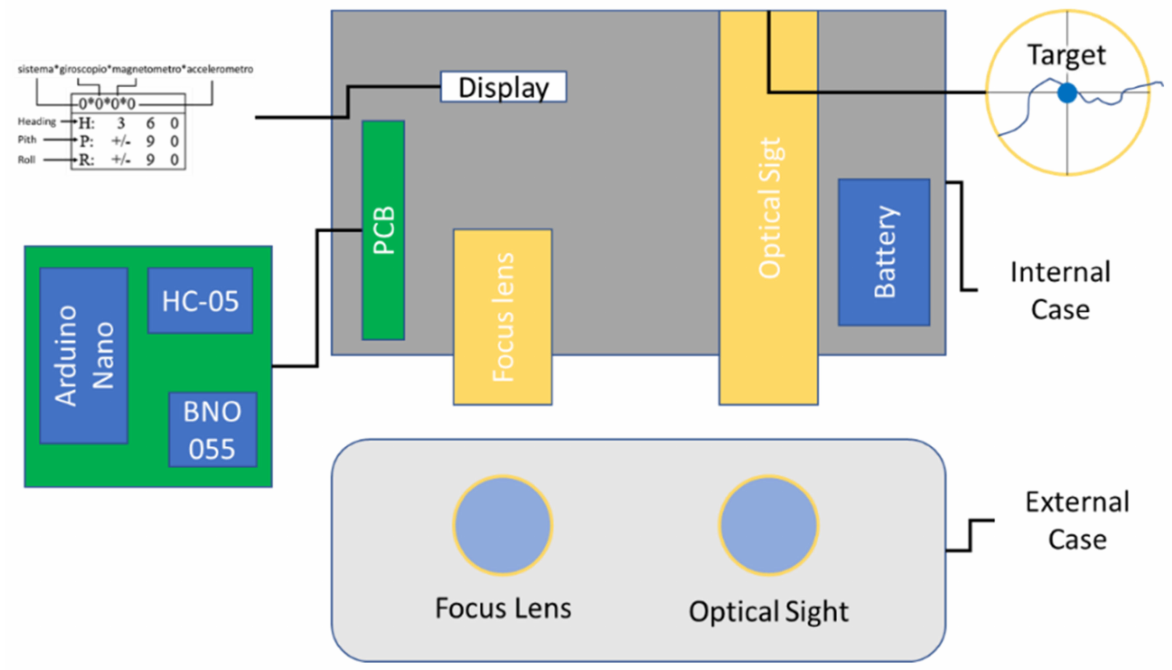
Figure 6. RANGER components